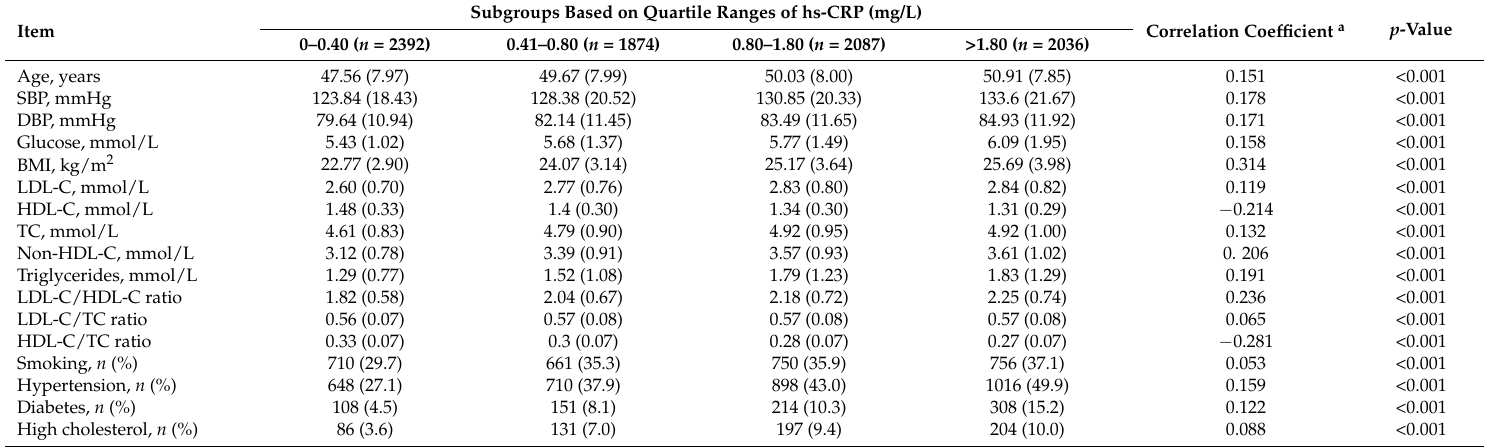
Table 3. Correlation analyses of different subgroups based on quartile ranges of hs-CRP concentrations and the corresponding cardiovascular risk